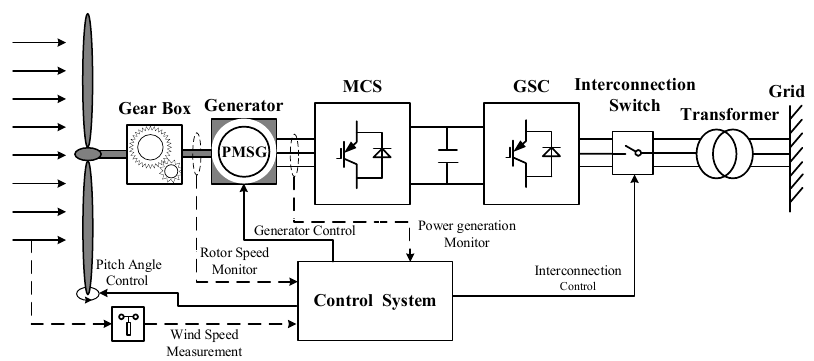
Fig. 1. The structure of direct-drive wind turbine